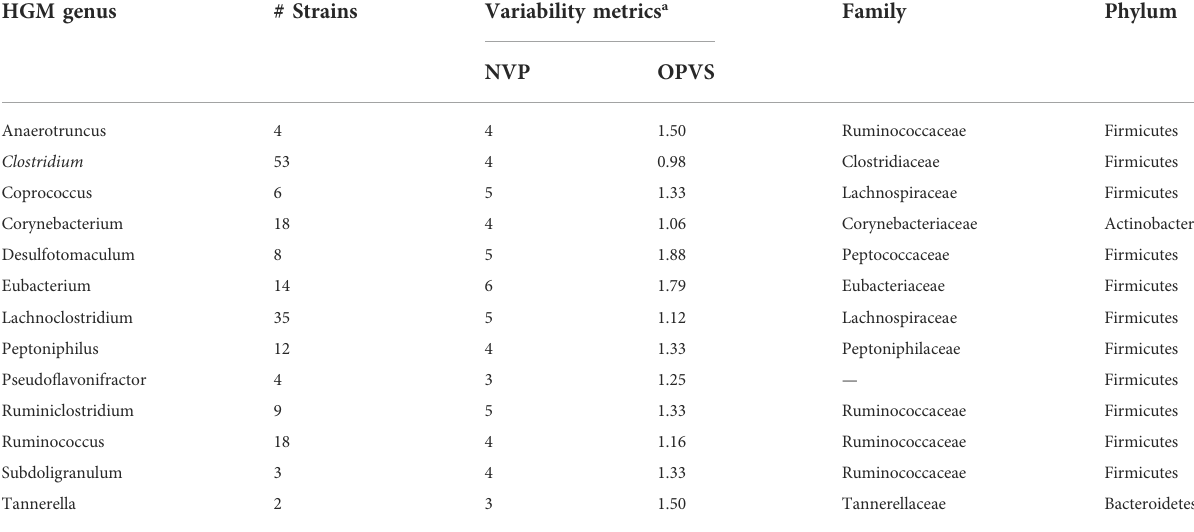
TABLE 2 Taxonomic genera with high variability of SCFA binary metabolic